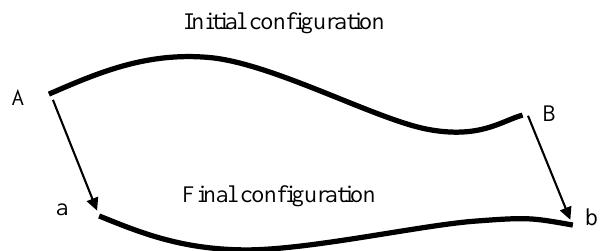
Figure 3. Compliant-segment motion generation (Saggere and Kota,